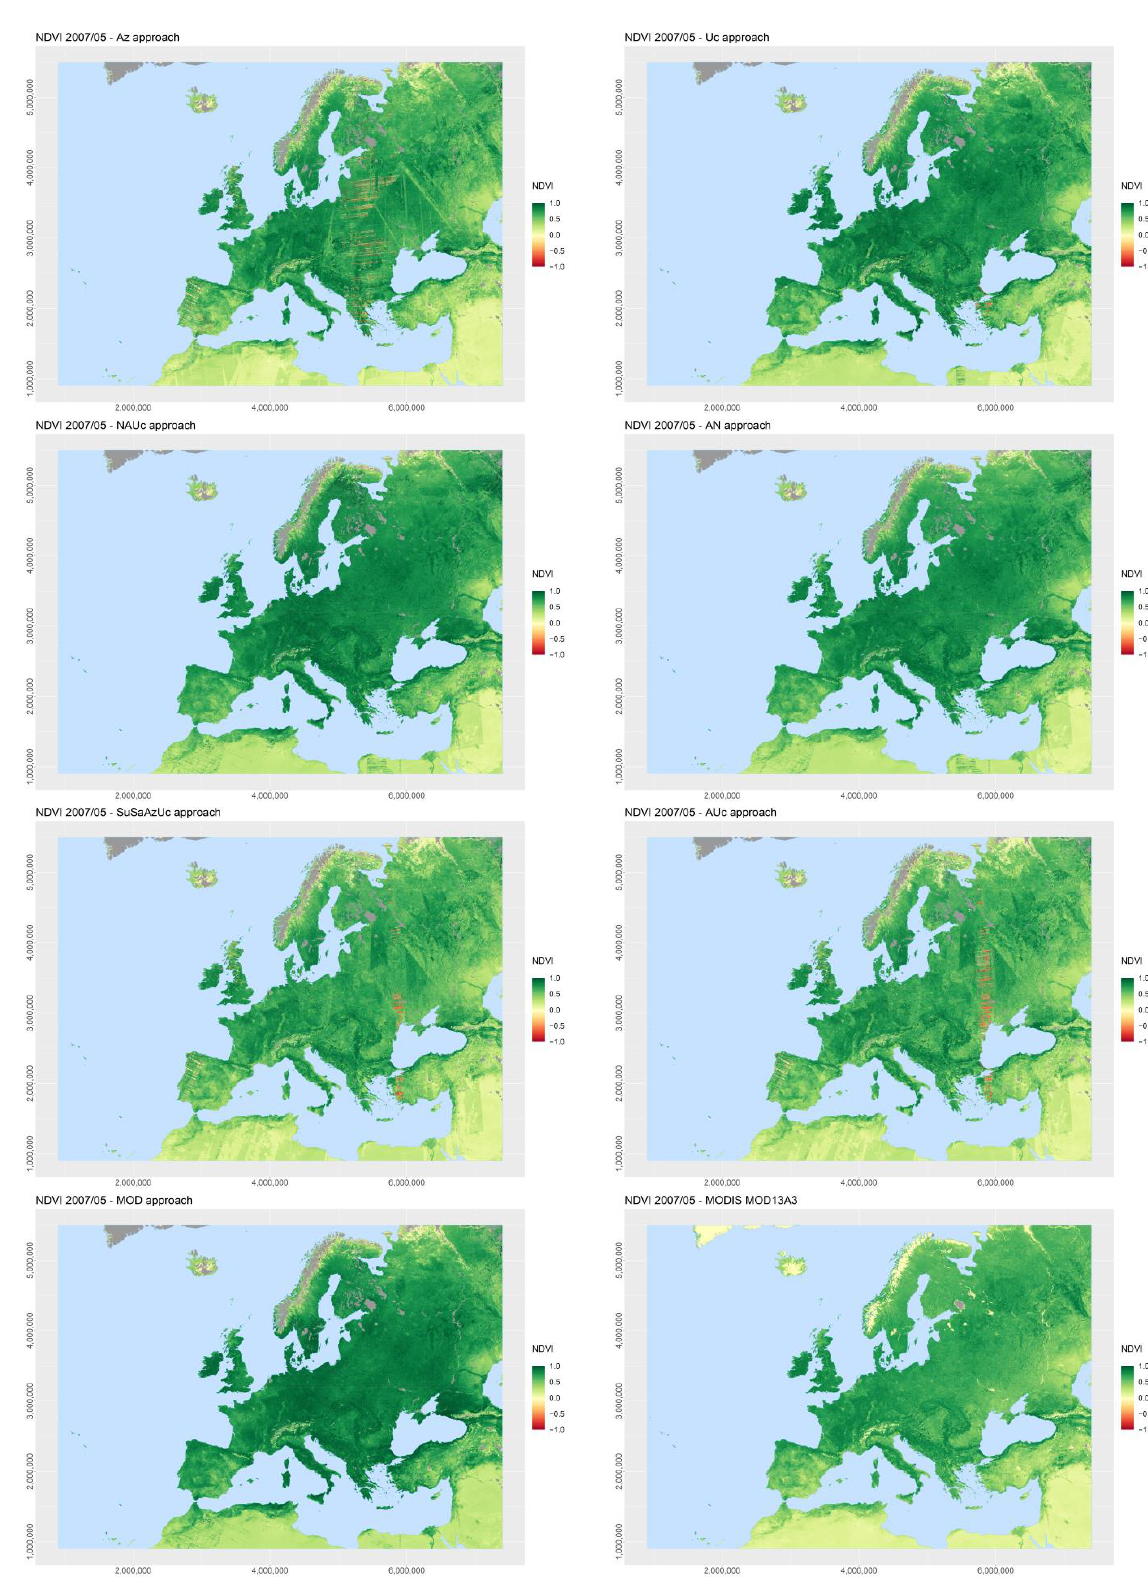
Figure 5. Monthly NDVI maps based on the different compositing approaches for May 2007. The MOD13A3 product of the same month is shown for comparison in the lower right